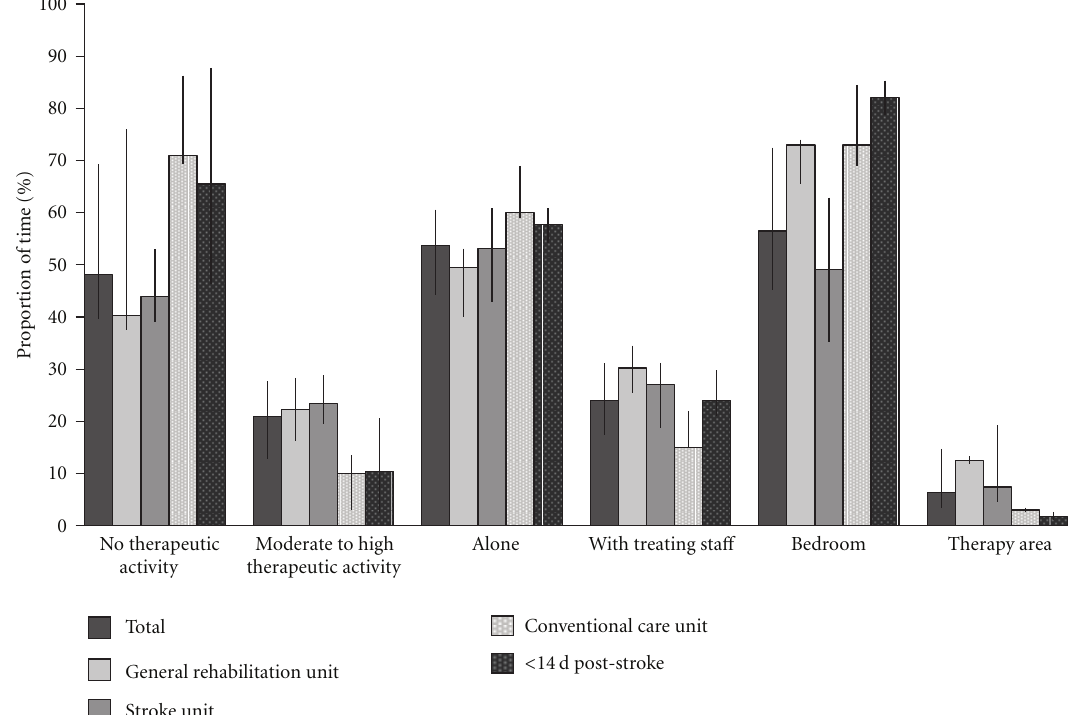
Figure 4: Patient activity, people present, and location according to organisation of care and time after stroke. median and IQR.